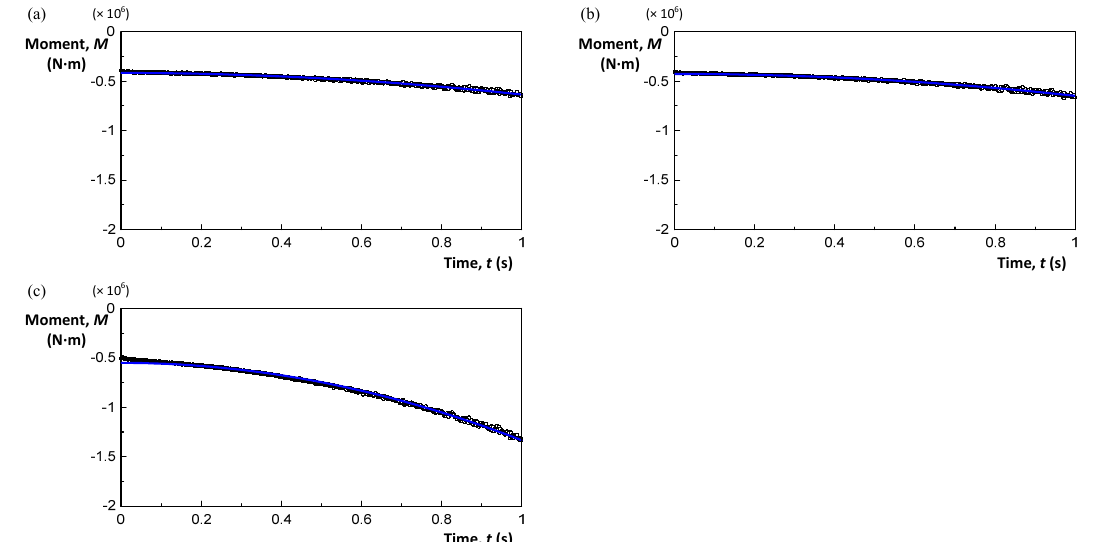
Figure 8. The external force is received by the duct under the translational motion of six degrees of freedom (6DoF). ( a ) Surge; ( b ) Sway; ( c ) Heave. ○ , simulation values; ― , Equation (10).